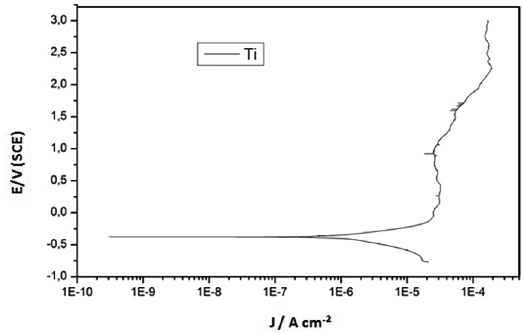
Figure 4. Polarization curves for Cp Ti in NaCl 0.15M + NaF 0.03M